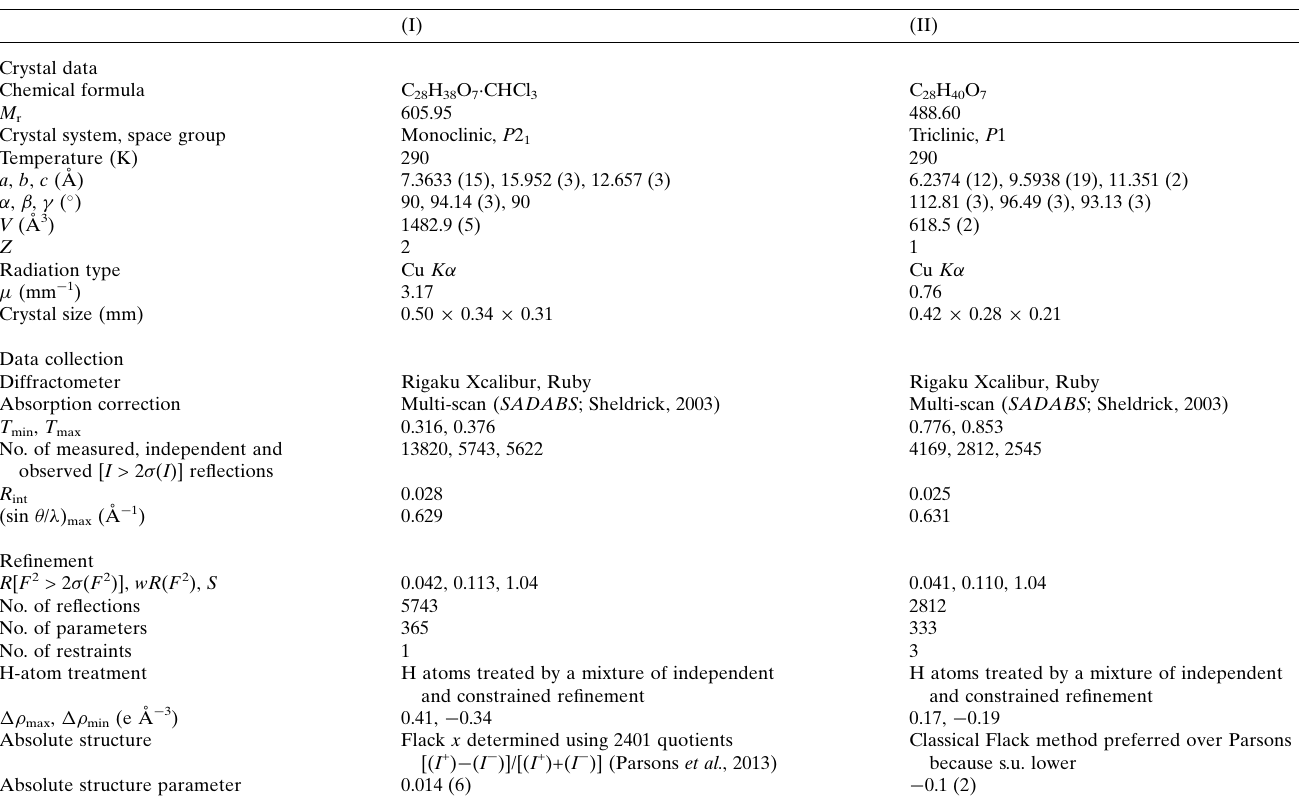
Table 3 Experimental details.